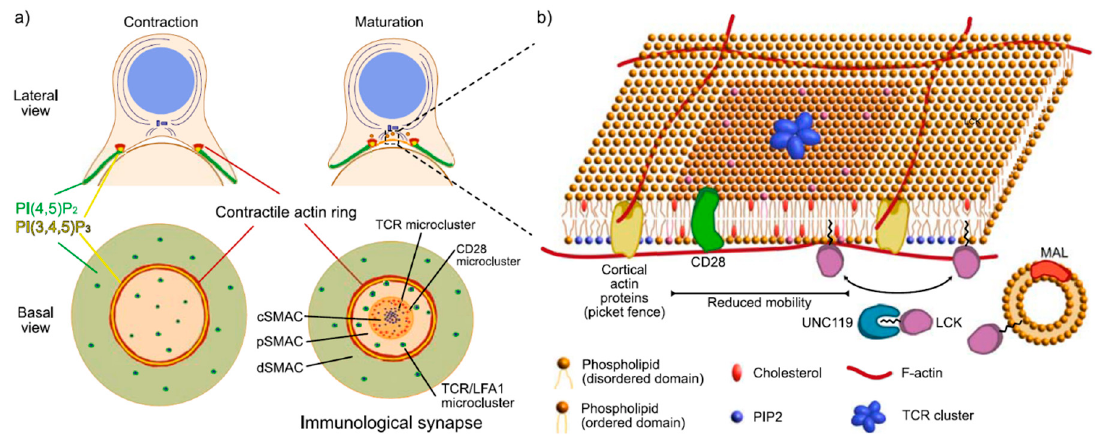
Figure 2. Spatial regulation of signaling at the immunological synapse. ( a ) The schematic shows maturation of the T cell-APC interaction to the IS. The lateral view shows the stage of polarization of the T cell: The centrosome is recruited underneath the cell–cell interphase and there is active transport of proteins and vesicles towards the APC, while the nucleus moves to the rear area of the cell. To mediate cell contraction and retrograde flow of molecules to the center of the interphase, a contractile actin ring develops which coincides with an annular distribution of PI(3,4,5)P 3 . PI(4,5)P 2 and PI(3,4,5)P 3 regulate actin clearance from the center of the synapse. After maturation and formation of the IS, signaling molecules are sorted into the supramolecular activation centers (SMACs): central (c), peripheral (p), and distal (d) SMACs. Clusters of TCR, CD28, and TCR combined with other signaling molecules like LFA-1 are sorted into different SMACs during the maturation of the synapse. ( b ) The schematic shows some of the strategies cells rely on to generate specialized membrane domains and how they influence mobility of molecules within and between domains. Highly ordered lipid domains contain a higher percentage of saturated fatty acids, sphingomyelin, and cholesterol, as well as highly packed phospholipids. Distribution of phosphatidylinositols such as PI(4,5)P 2 and PI(3,4,5)P 3 also generates membrane domains that lead to a distinctive interaction of the membrane and the actin cytoskeleton. Actin filaments together with cortical actin proteins such as ankyrin or spectrins as well as transmembrane proteins generate barriers to free diffusion of molecules that act as picket fences, creating confinement of molecules within the compartment. TCR clusters and other protein clusters frequently localize to highly ordered lipid domains, since assembly of lipid and protein clusters are closely connected. Several proteins are specifically localized to highly ordered lipid domains, usually through lipid modifications (myristoilation, palmytoilation, etc.); such is the case of LCK that is myristoilated and targeted to condensed domains by myelin and lymphocytes protein (MAL)-positive vesicles. LCK might translocate from vesicles to the plasma membrane and between membrane domains (overcoming potential diffusion barriers) by UNC119.